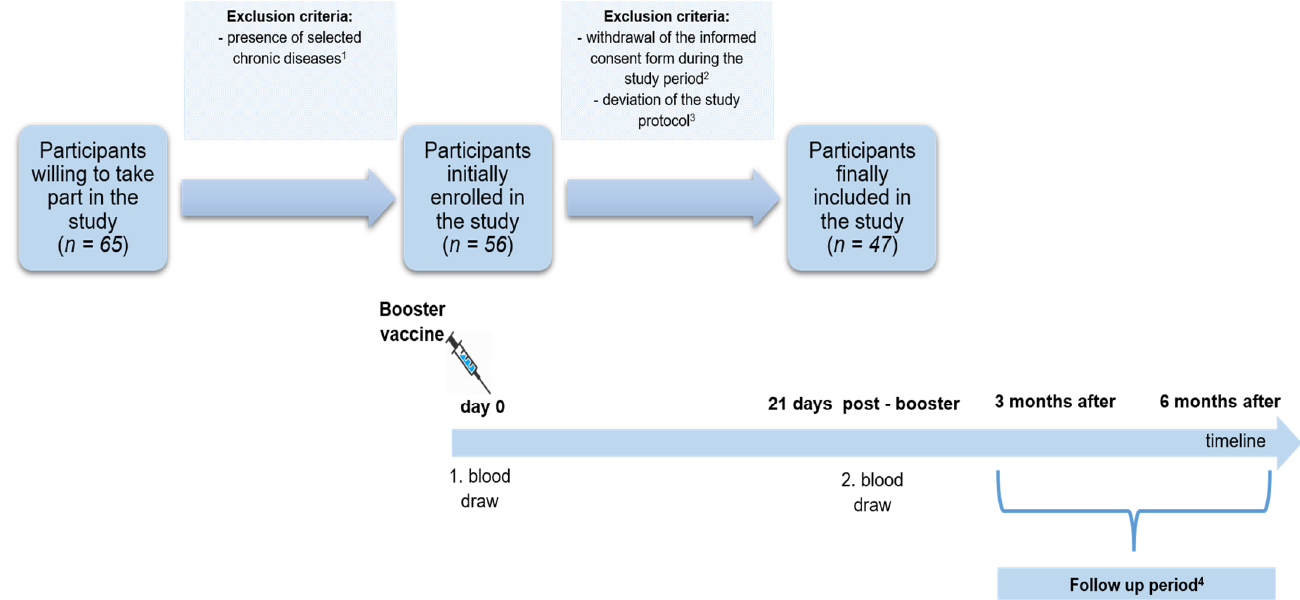
Figure 1. The study flowchart: study timeline and selection of the study group based on the exclusion criteria. Legend: 1 the presence of selected chronic diseases affecting immunoreactivity (i.e., autoimmune diseases, including Hashimoto’s disease, chronic obstructive pulmonary disease, diabetes); 2 withdrawal of the informed consent from the study (for personal or other reasons); 3 deviations of the study protocol (i.a., not being able to participate in the second blood collection 21 days after receiving the booster); 4 6-month follow-up period after receiving a booster with potential occurrent SARS-CoV-2 infection (only RT-PCR confirmed) measured within three time intervals: <21 days (early follow-up, early FU), ≥ 21 days to 3 months (intermediate follow-up, intermediate FU), ≥ 3 to 6 months (late follow-up, late FU). Abbreviations: FU—follow-up. Information on COVID-19 status before and after the booster dose was reported by respondents through the study authors’ survey and verified during telephone interviews.